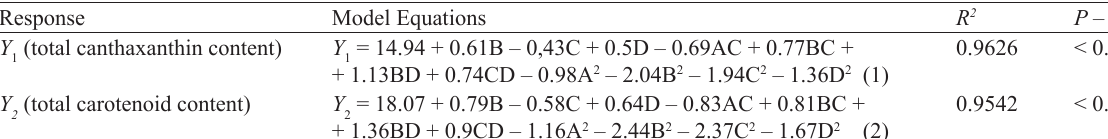
Table 4 Empirical second-order polynomial model of canthaxanthin and total carotenoid contents